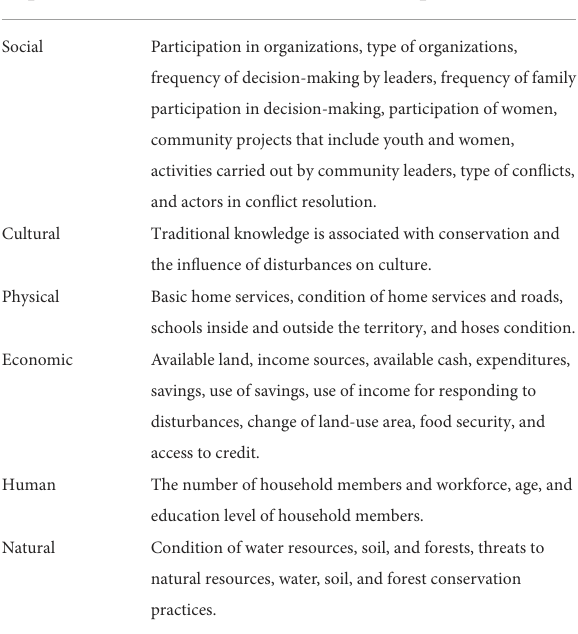
TABLE 1 Variables for the analysis of community livelihoods per